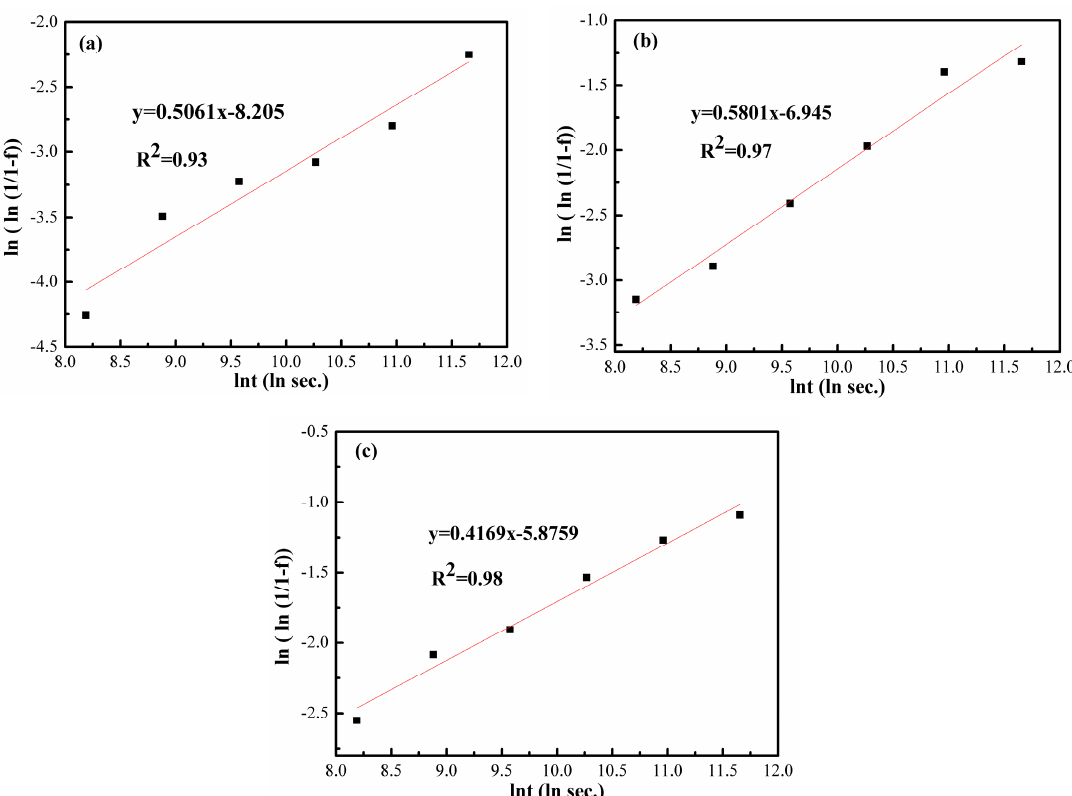
− 1 ) and ln t for the samples tempered at ( a ) 580 ◦ C ( b ) 600 ◦ C ))1ln(ln( 1 − − f t ln and for the samples tempered at ( a ) 580 °C ( b )